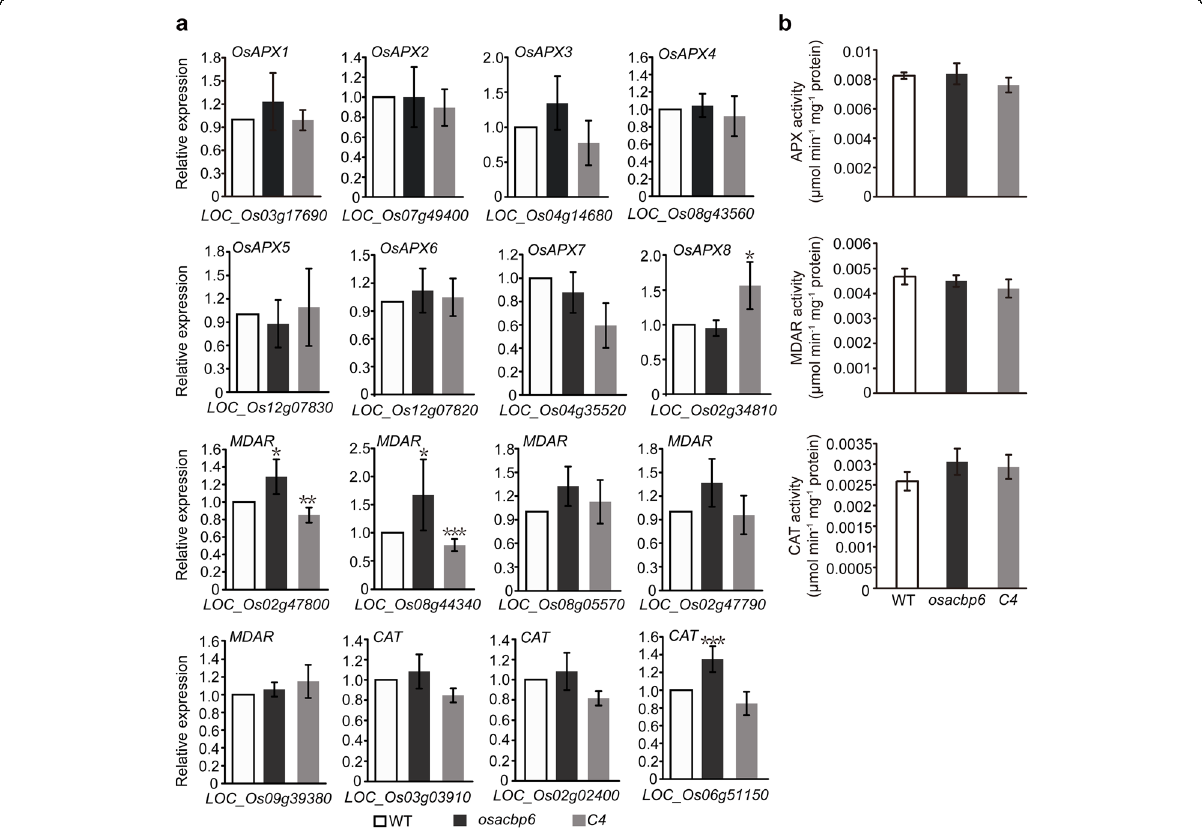
Fig. 6 The expression levels and activities of rice genes associated with reactive oxygen species scavenging. a Relative expression in the leaves of 21-day-old wild type rice (WT), osacbp6 and complemented lines osacbp6 - C4 ( C4 ) were determined by quantitative real time RT- PCR (qRT-PCR). Values are means ± SD ( n = 3). b Comparison of activities of APX, MDAR and CAT. Enzyme activity was detected from 21- day-old leaves of WT, osacbp6 and C4 . Values are means ± SD ( n = 3). Asterisks indicate significant differences as evaluated by Student ’ s t